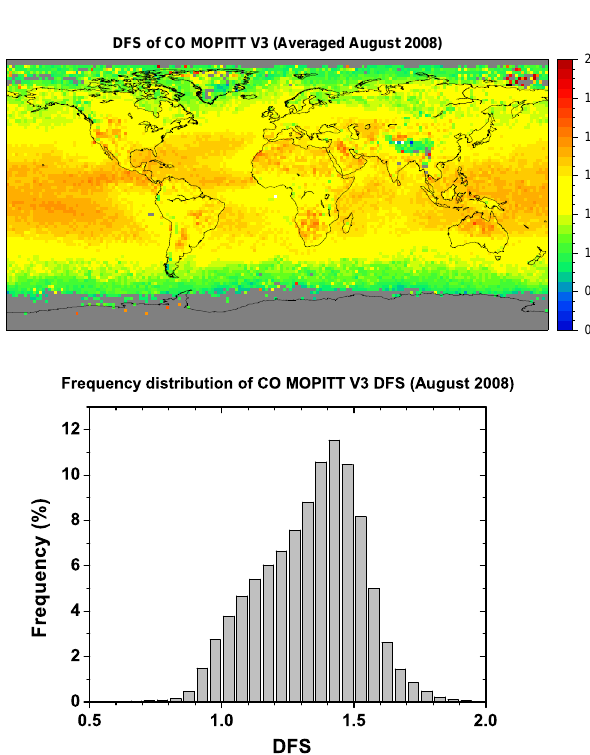
Figure 1. Top: longitude–latitude map of the averaged DFS param- Fig. 1. (Top):Lon-lat map of the averaged DFS over August 2008 corresponding to the vertical profiles of eter over August 2008 corresponding to the vertical profiles of MO- MOPITT 3. (Bottom): the frequency distribution of the DFS corresponding to all vertical profiles measured PITT 3. Bottom: the frequency distribution of the DFS parameter during the same period. corresponding to all vertical profiles measured during the same pe-